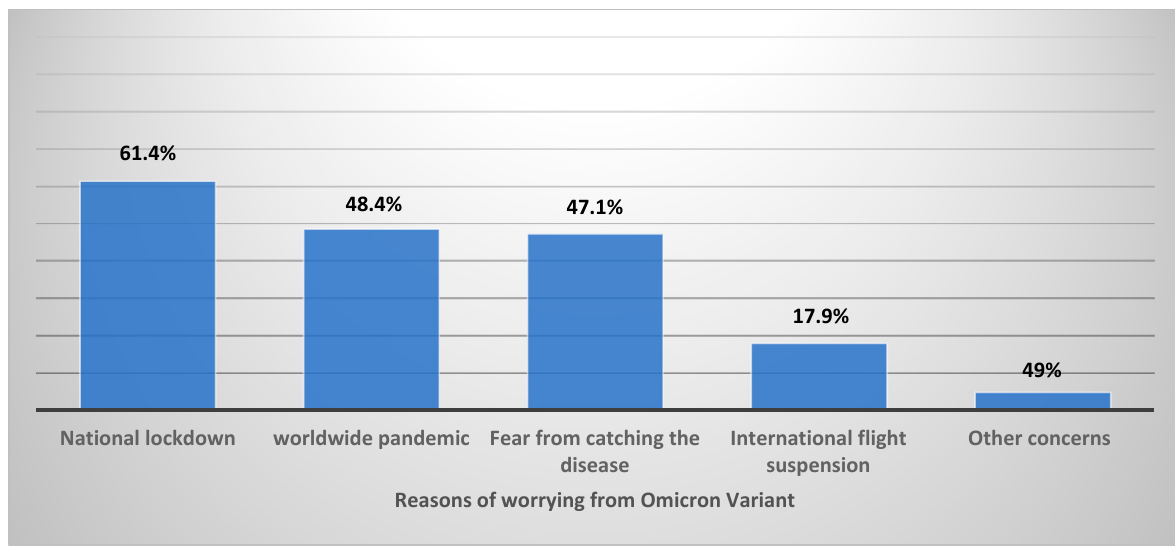
Figure 1. Parents’ Omicron worry level in comparison to the Delta variant.